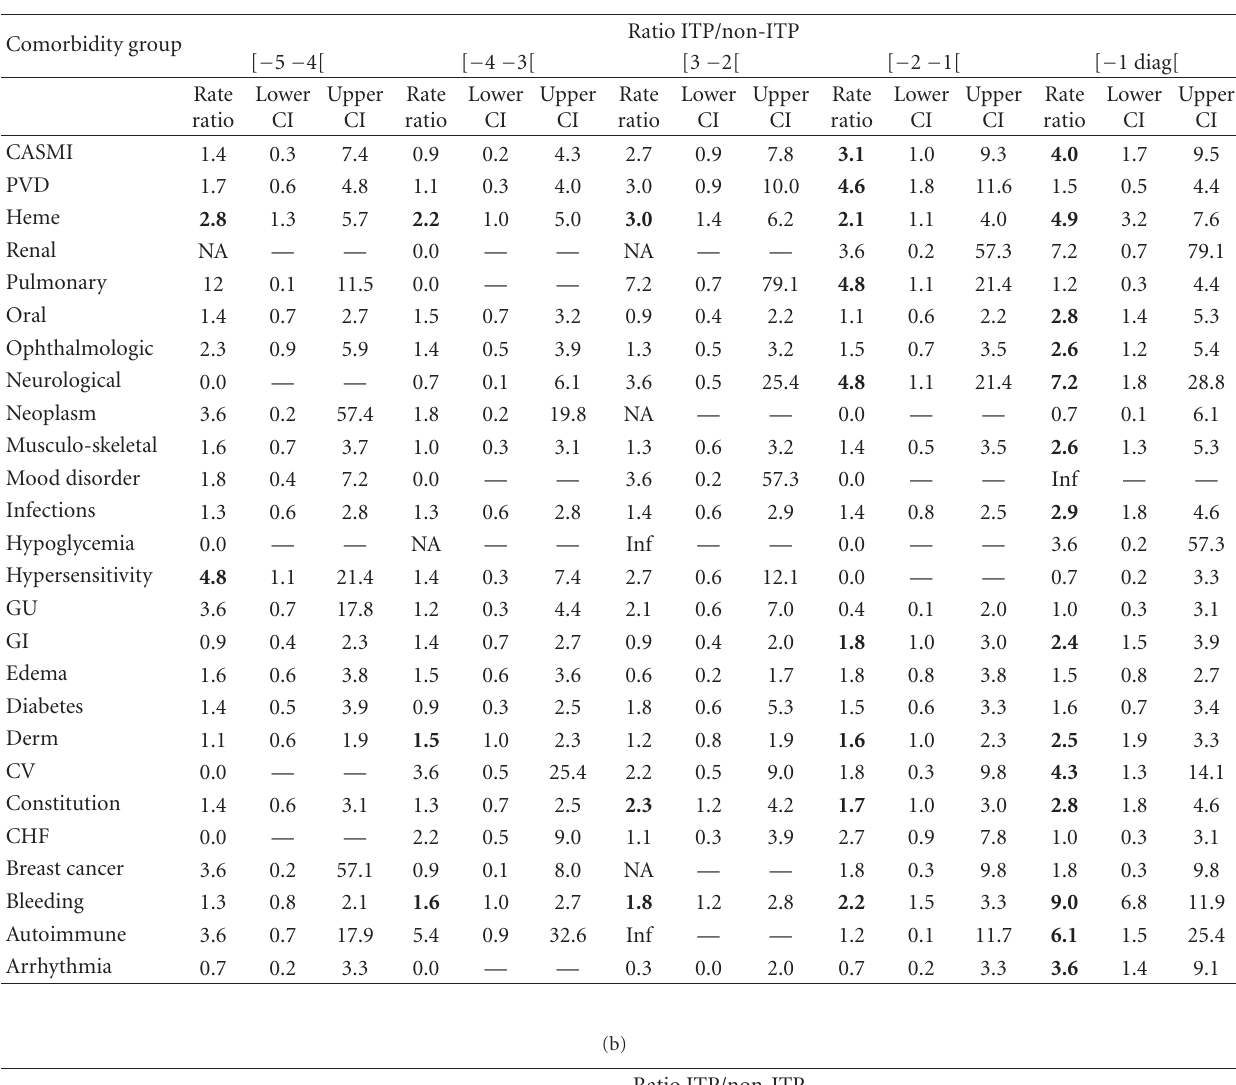
Table 5: Rate ratios and 95% CI between ITP and non-ITP patients for 26 grouped medical conditions.